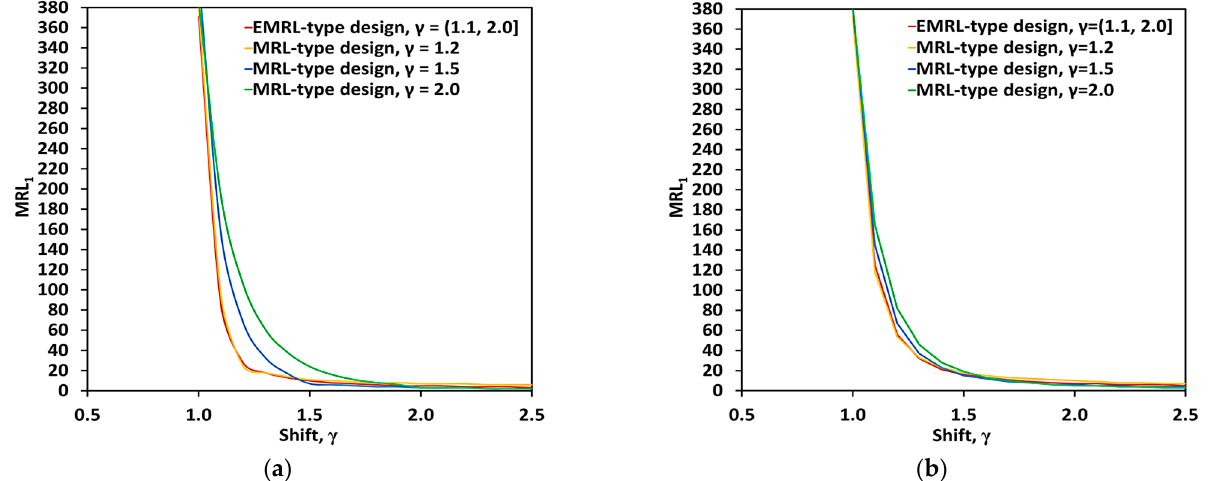
Figure 3. Comparison of the MRL values under ( a ) ZS and ( b ) SS for MRL- and EMRL-based SDS np designs.